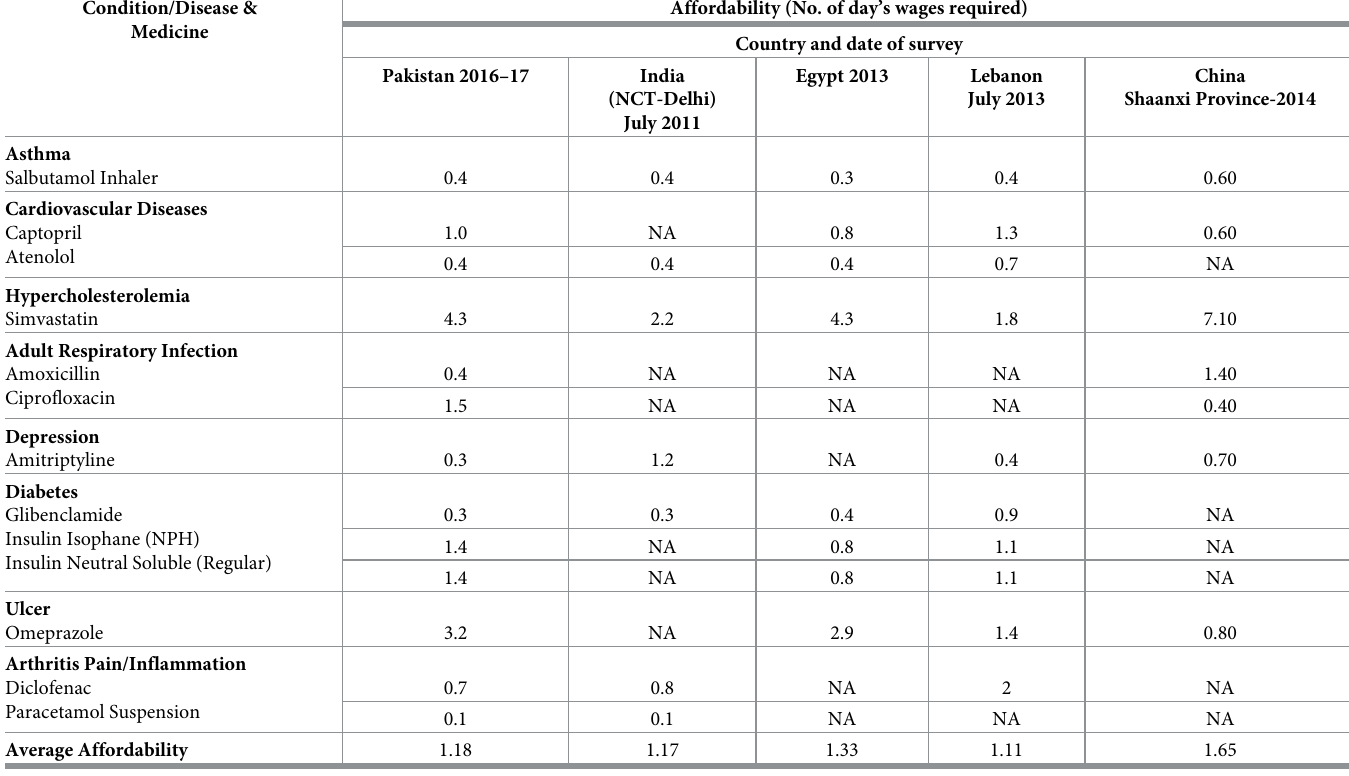
Affordability (No. of day’s wages